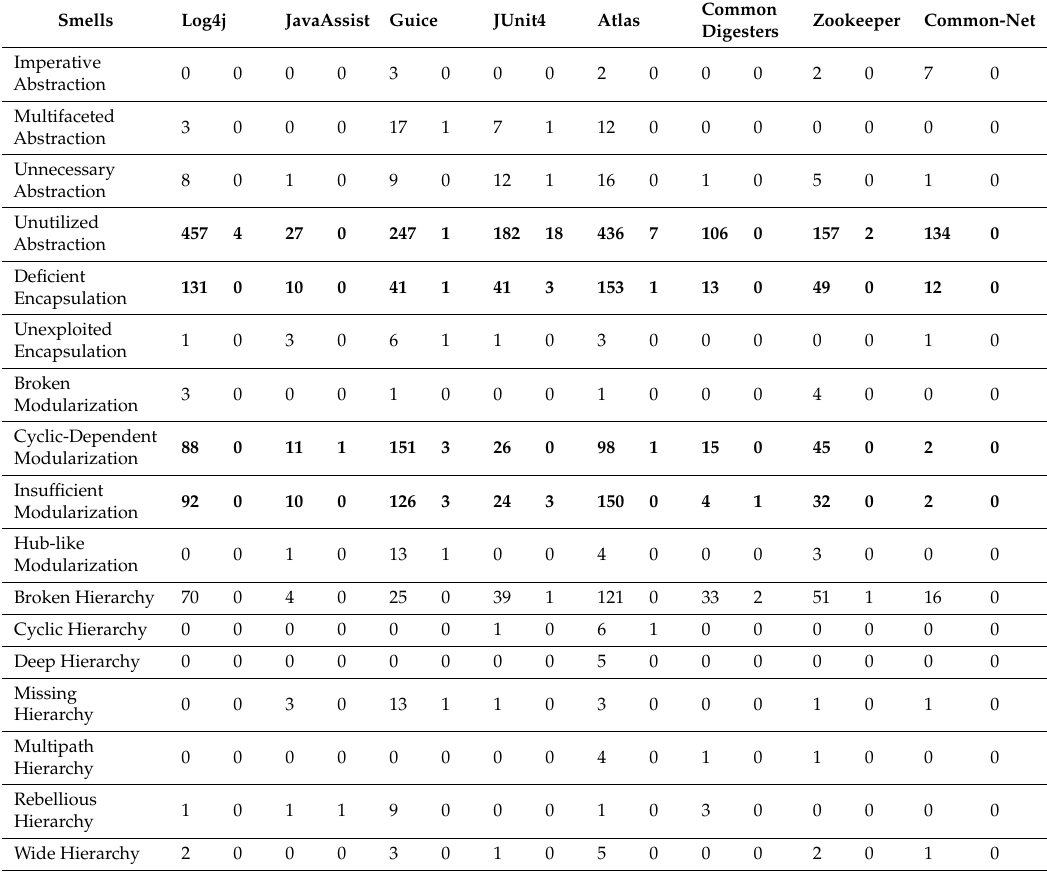
Table 9. Issue resolution in presence of smell